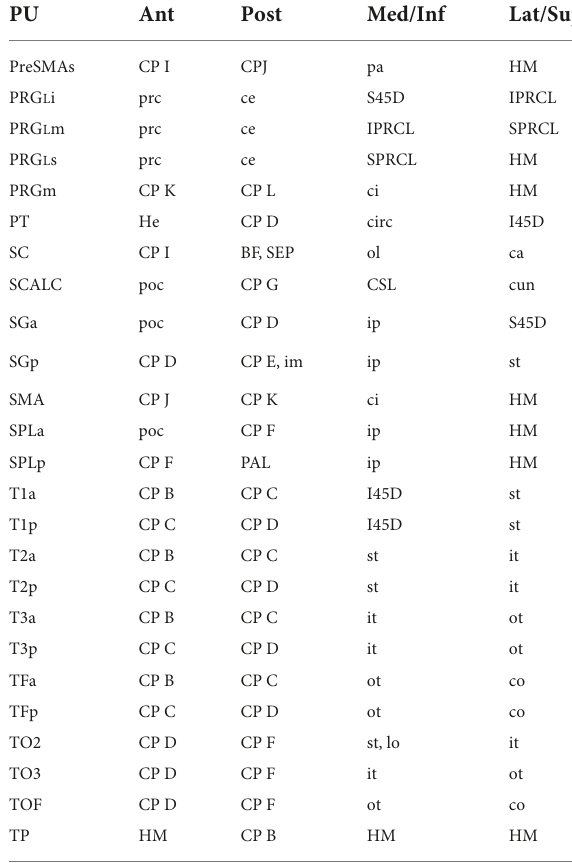
Abbreviations are found in Table 1 for parcellation units, and Table 3 for sulci. Coronal planes (CP) are listed in Table 2 . CIL, calcarine inferior line; CSL, calcarine superior line; HM, hemispheric margin; I45D, inferior 45 degree line of the Sylvian fissure; S45D, superior 45 degree line of the Sylvian fissure; IPOCL, inferior postcentral line;